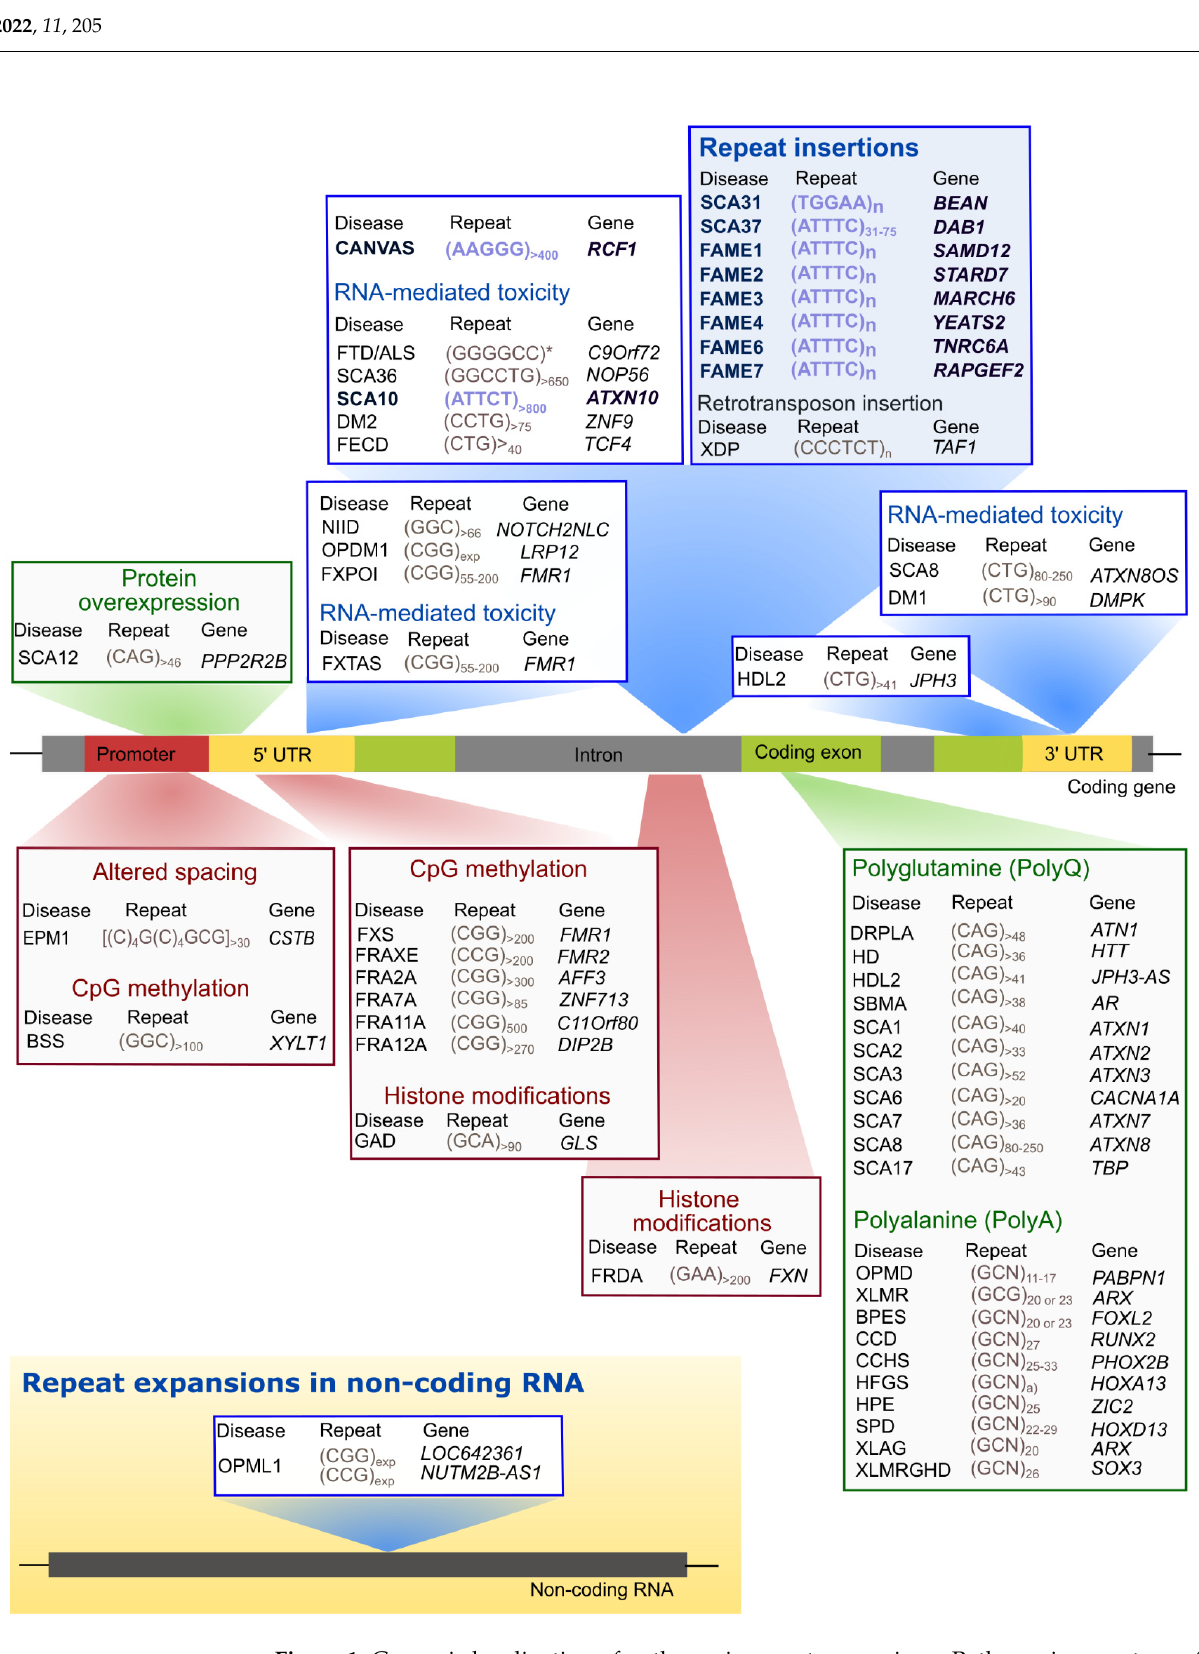
Figure 1. Genomic localization of pathogenic repeat expansions. Pathogenic repeats are found in protein-coding genes or non-coding RNAs; in gene-coding regions, these repeats are found in promoters, 5 ′ UTRs, exons, introns and 3 ′ UTRs; in red boxes are represented expanded repeats that trigger gene silencing or downregulation (gene loss-of-function); in blue boxes the non-coding transcribed repeat expansions (RNA-mediated toxicity); in green boxes are expanded repeats